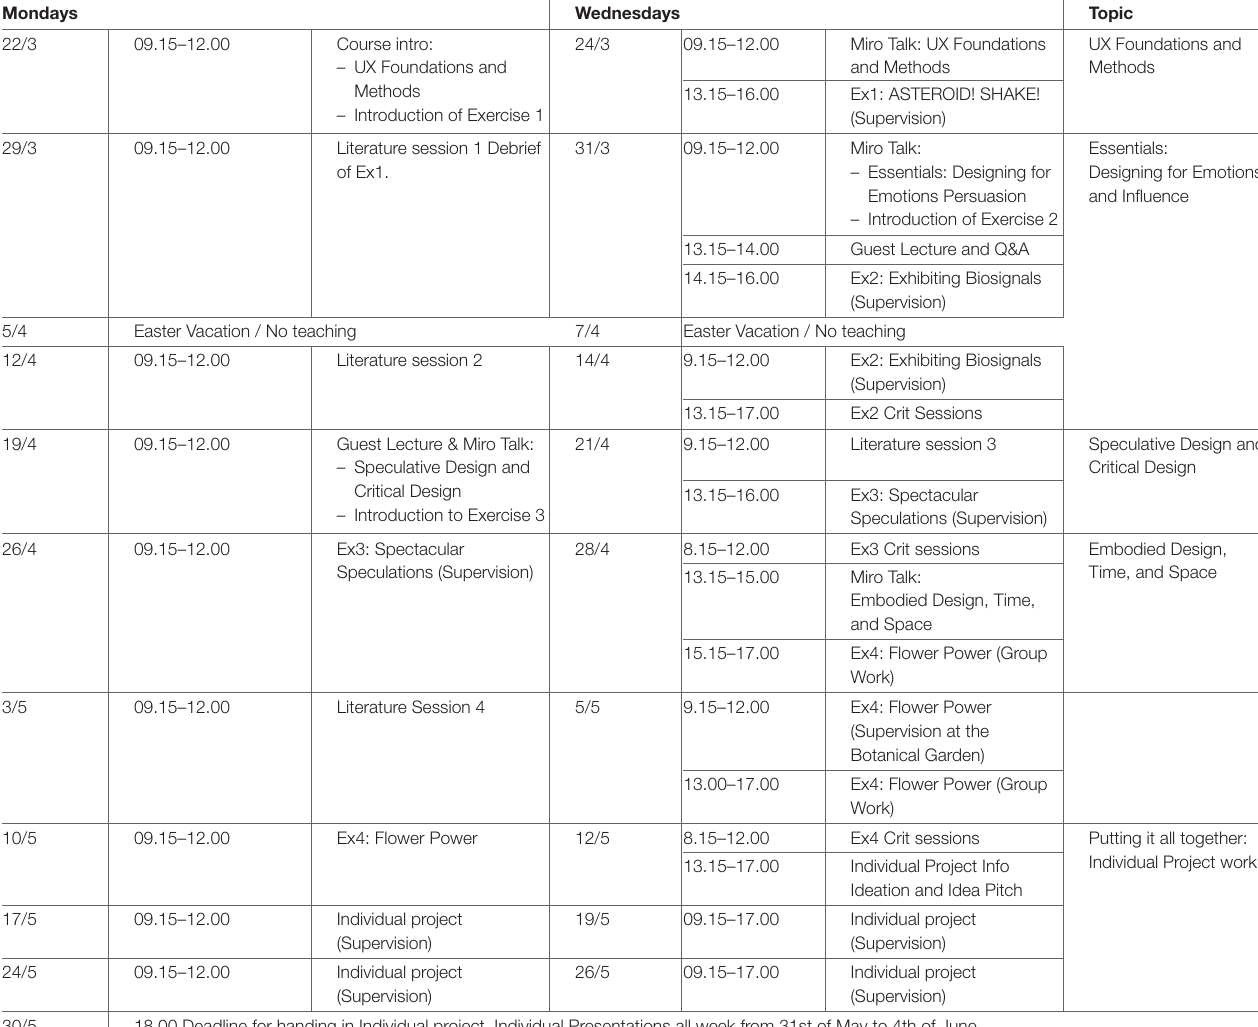
TABLE 2 | Table with the full schedule for the DUX course as conducted in